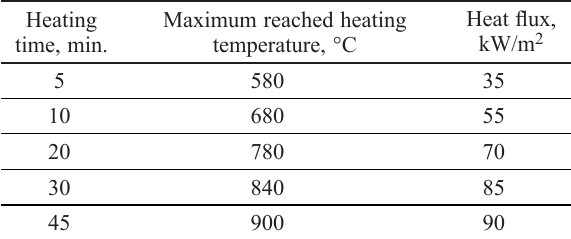
table 1. the dependency of the maximum reached temperature and heat flux in the heating chamber on time Heating time,